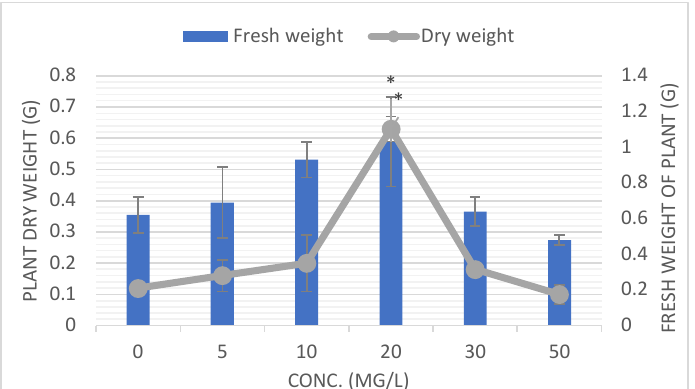
Figure 2. Fresh and dry weight of Cajanus cajan grown under the influence of SA of varying concentration * means significant difference at